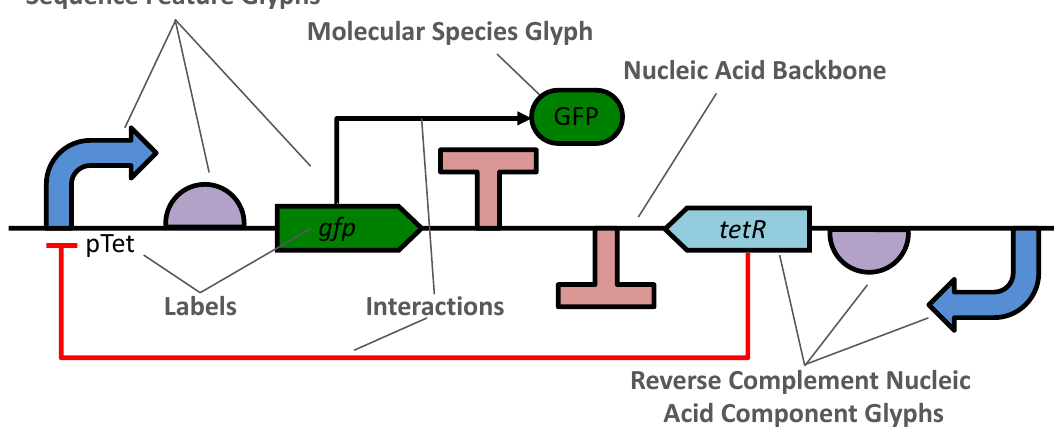
Figure 5: Example illustrating the elements of an SBOL Visual 2 diagram, with nucleic acid sequence features on the forward and reverse strand of a backbone, other molecular species, and interactions between elements; the grey labels and indicator lines are annotations.